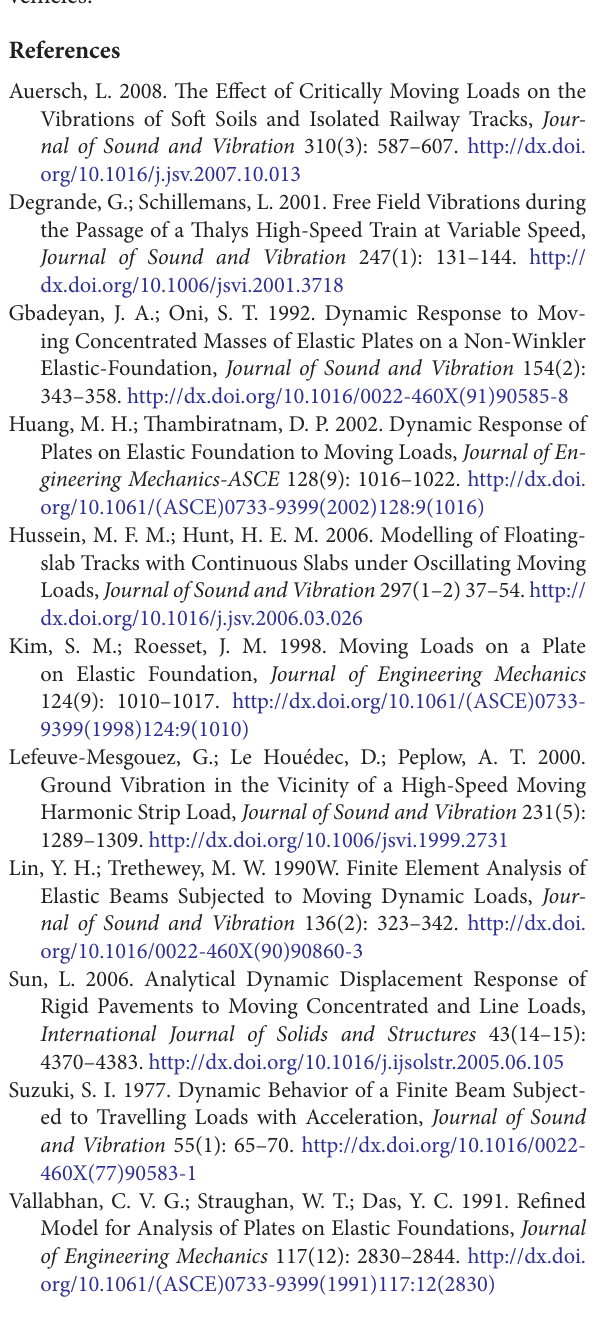
Fig. 7. Max displacement of the plate with different decelerations and fixed velocity